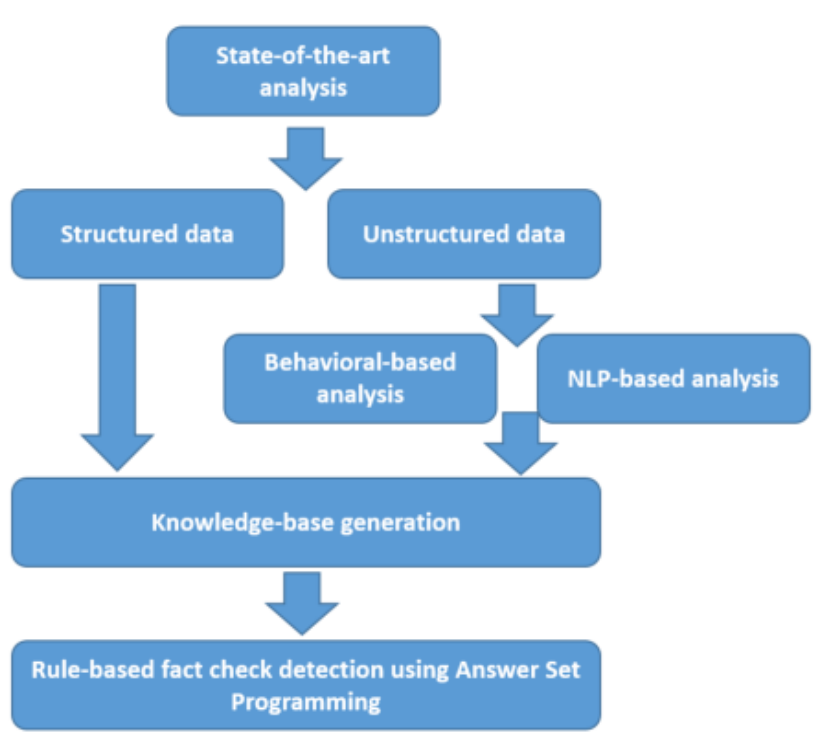
Figure 2. Process for structured and unstructured